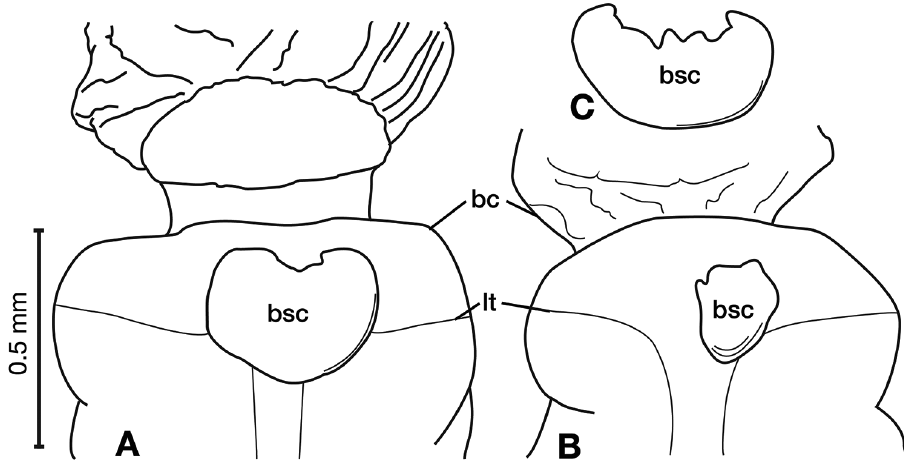
Figure 33. Line drawings comparing the bursal sclerite, ventral aspect of A Catascopus ( Catascopoides ) horni Jedlička B Catascopus ( s. str. ) sauteri Dupuis C C. ( Catascopoides ) mirabilis Bates (not present in Taiwan) Legend: bc bursa copulatrix; bsc bursal sclerite (type 1); lt lateral